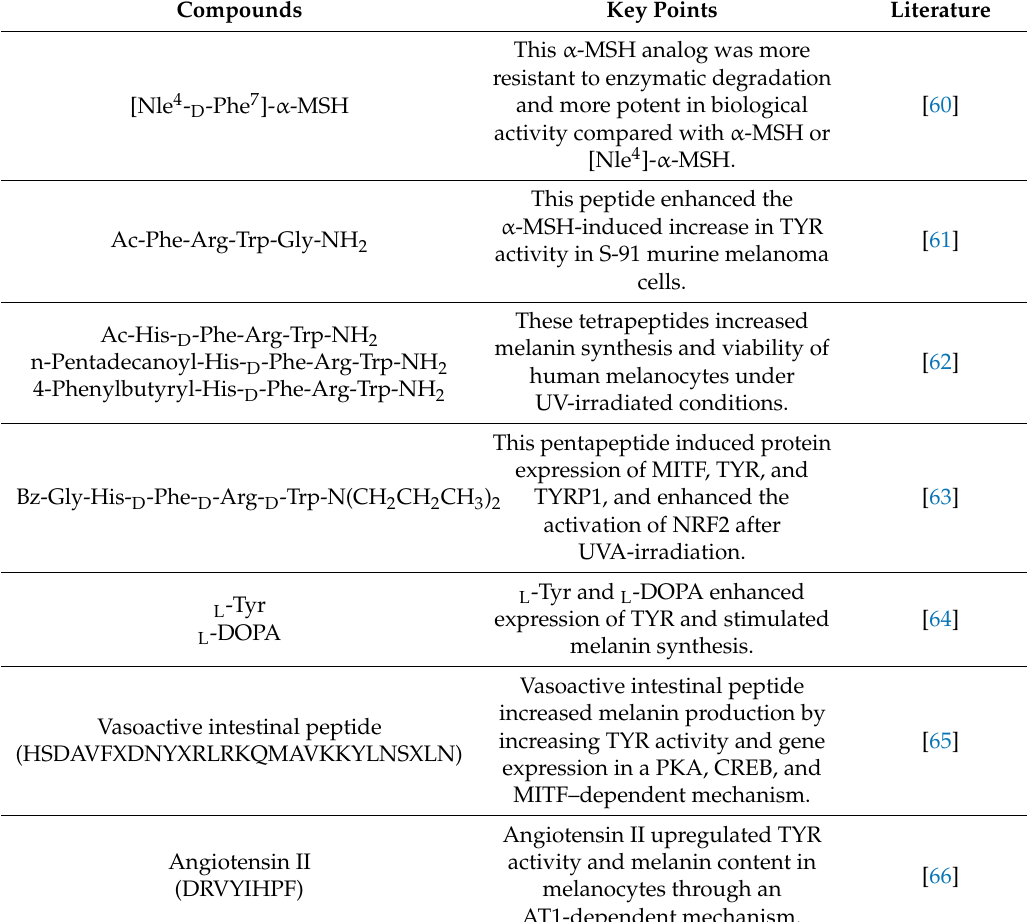
Table 1. Amino acids, peptides, and their analogs that stimulate melanin